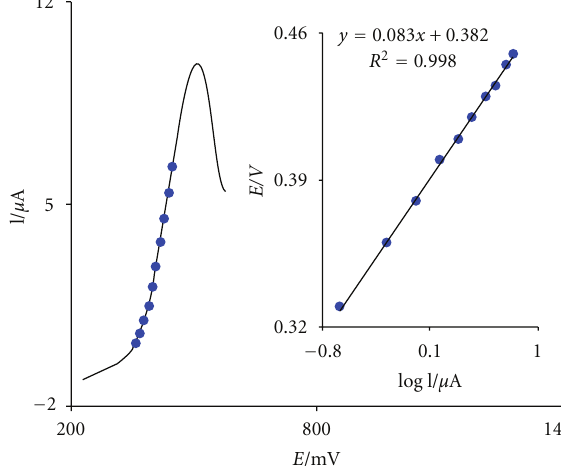
Figure 3: Linear sweep voltammogram (at 10mVs − 1 ) of FCDC- NPE in 0.1 M PBS (pH 5.0) containing 0.15mM CD. The points are the data used in the Tafel plot. The inset shows the Tafel plot derived from the linear sweep voltammogram.